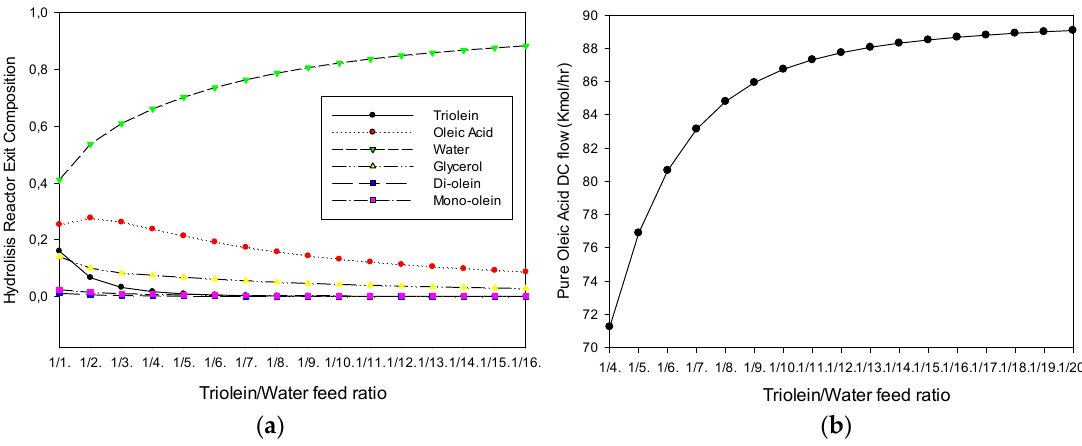
Figure 3. ( a ) Effect of the triolein-water feed ratio on the hydrolysis reactor exit composition. ( b ) Effect of the triolein-water feed ratio on the distillation column bottom flow (stream 11).